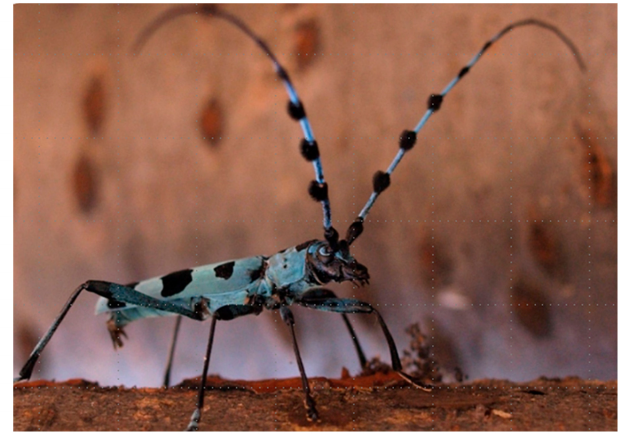
Figure 11. “Push-up stance” of Rosalia batesi male adult, with the abdominal tip raised